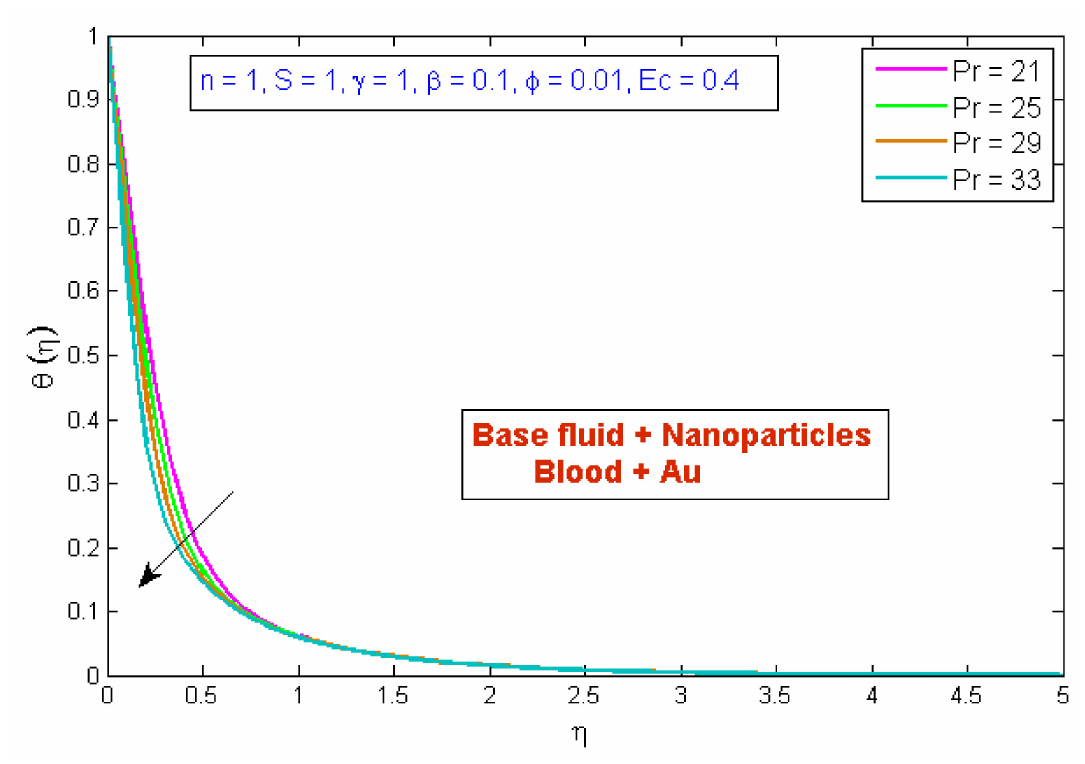
Figure 10. Modification of θ ( η ) versus Pr .